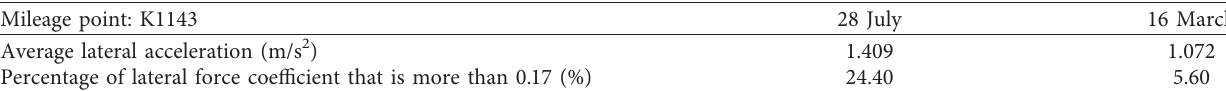
Table 4: Lateral force coefficient and lateral acceleration at K1143.